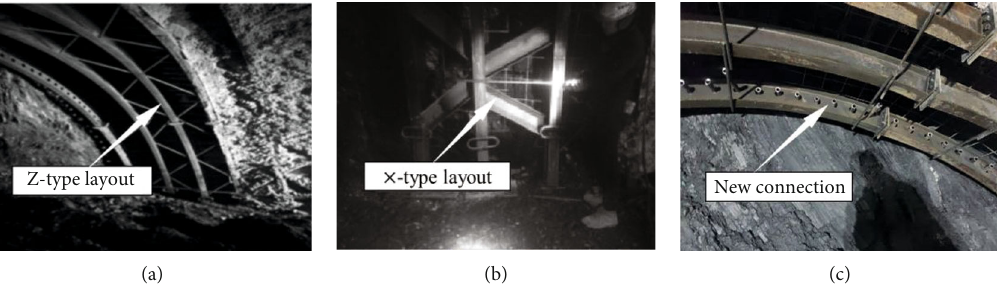
Figure 14: Optimal design of arch